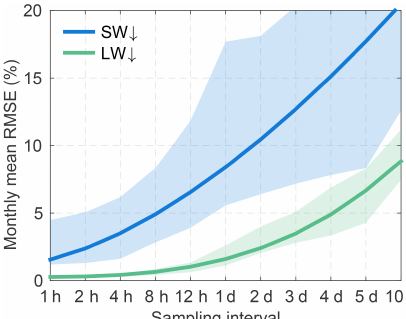
Figure 4. Monthly mean SW ↓ and LW ↓ RMSE (%) in function of sampling interval as derived from six AWSs. The RMSE was cal- culated by comparing the monthly mean estimates based on a sub- sample of data with a specified sampling interval to the full hourly datasets. The two curves represent the average relationship, while the shaded areas indicate the range for the different stations. Ob- servation times range from 2007 to 2010, although with varying availability for the different